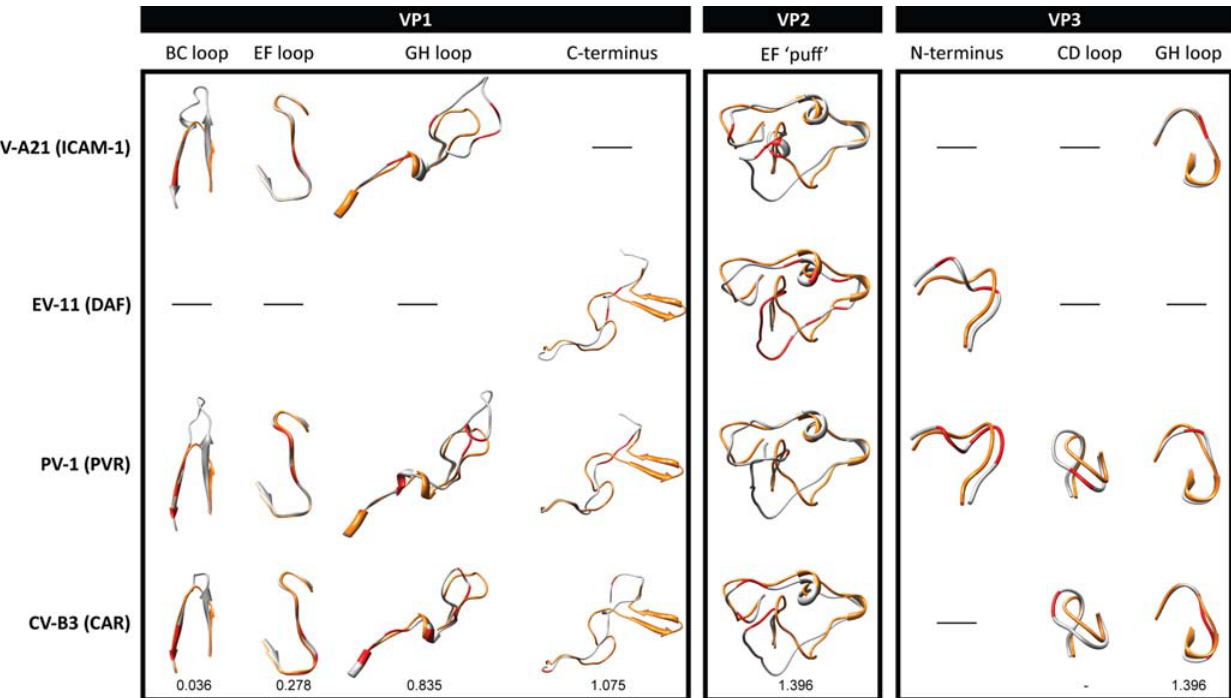
Figure 4. Comparison of HRV-QPM and HEV structures at the sites comprising HEV receptor footprints. Figures indicate comparison of the predicted structures of HRV-QPM (orange) with representative HEVs (gray) in regions identified as HEV receptor footprints (red) across VP1, VP2 and VP3 proteins. RMSD values shown for conformational comparison of CAR and HRV-QPM structures, in angstroms.